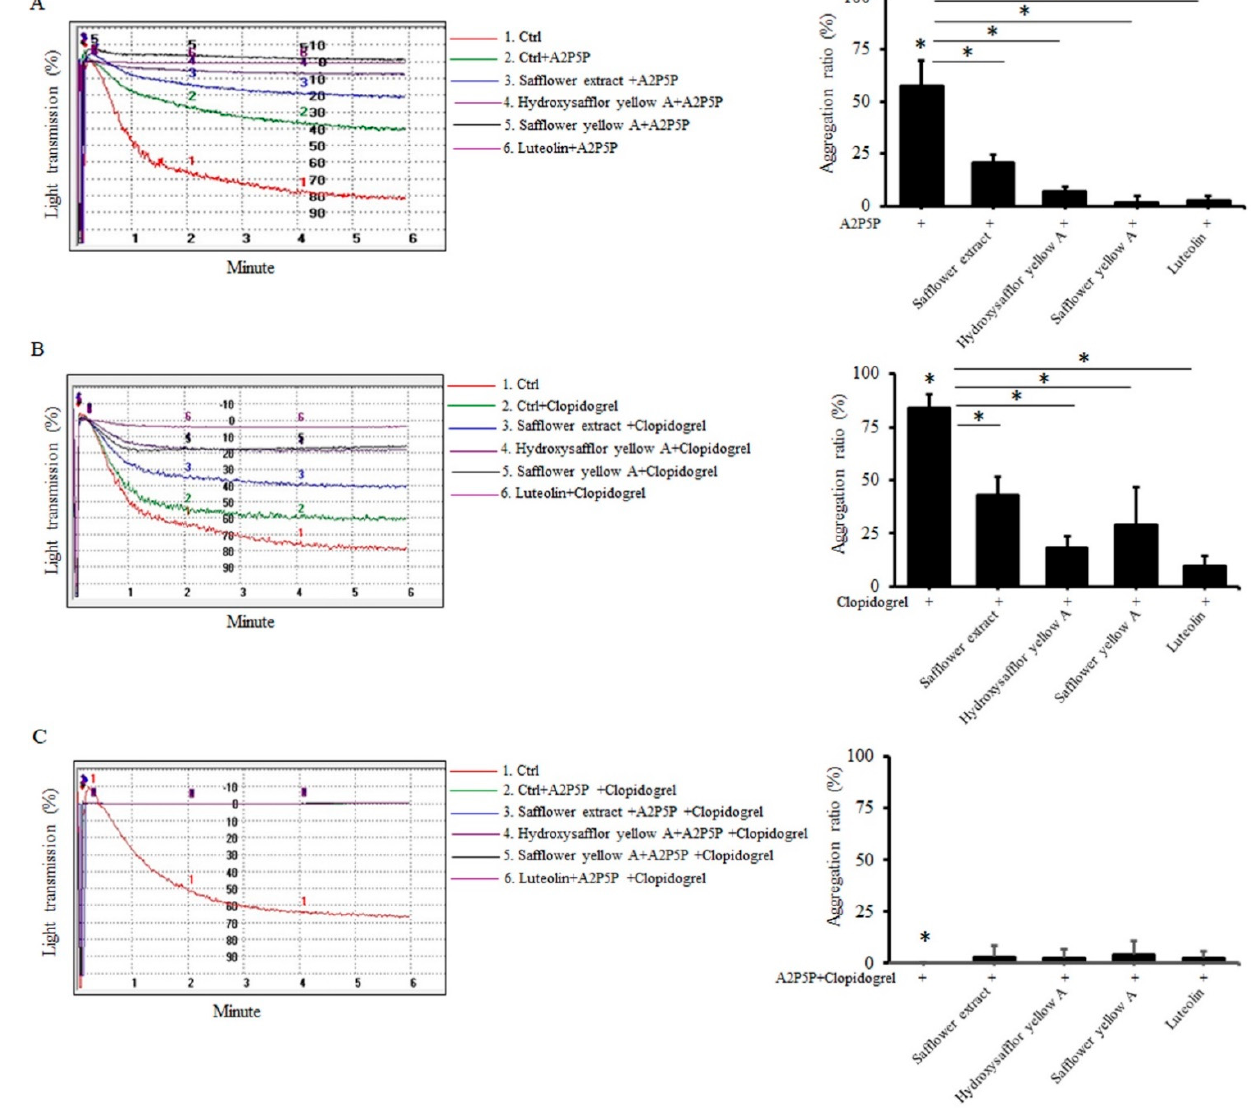
Figure 3. The effect of the ADP receptor antagonist on the inhibition of platelet aggregation by safflower extract. PRP was treated with 50 μ g/mL safflower extract or 25 μ g/mL of compounds found in safflower extract, 10 μ M ADP and 1 mM A2P5P ( A ), 1 mM clopidogrel ( B ), or A2P5P+clopidogrel ( C ) added and analyzed by an aggregation analyzer. * p < 0.05 between two groups.